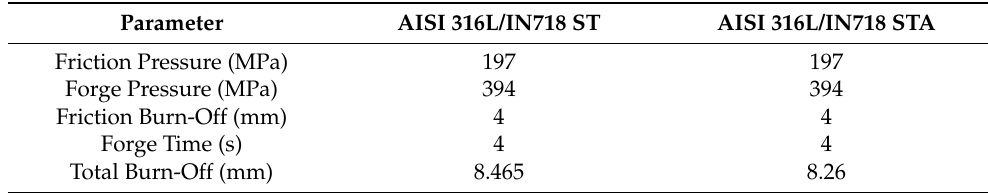
Table 3. Welding